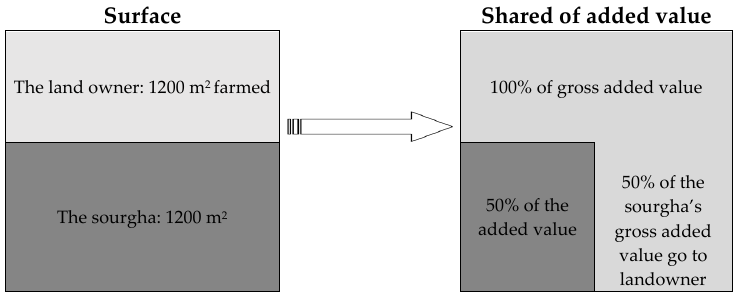
Figure 7. Representation of unequal development due to income partition between land owners and sourghas —Example of 1200 m 2 , which is the maximum surface in manual agriculture— The land owner accomplish his own farming on 1200 m 2 farmed (that is the maximum surface for one person with manual equipment) and keeps 100% of the added value he has generated. The sourgha who borrows 1200 m 2 to the landowner reassign 50% of the added value he has generated to the landowner. The two persons had the same level of effort but one (landowner) earns three times the income of the second ( sourgha ). Table 6. Added value partition between employer and sourgha within an onion manual cultivation system using a mbeye seddo (benefit sharing contract).